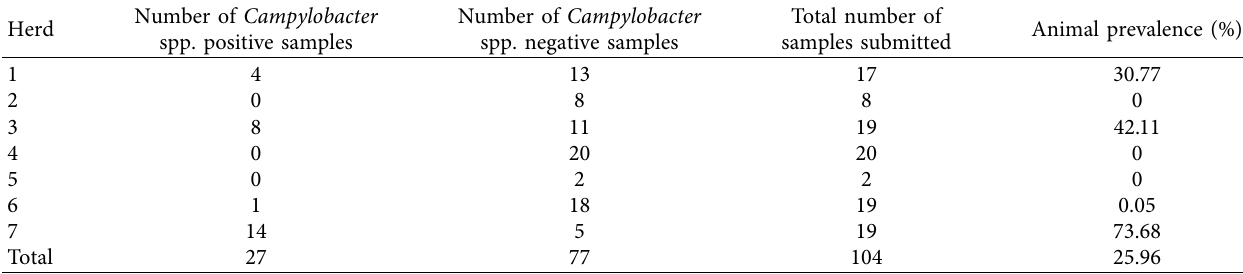
Table 1: Results of samples tested for Campylobacter spp. in the